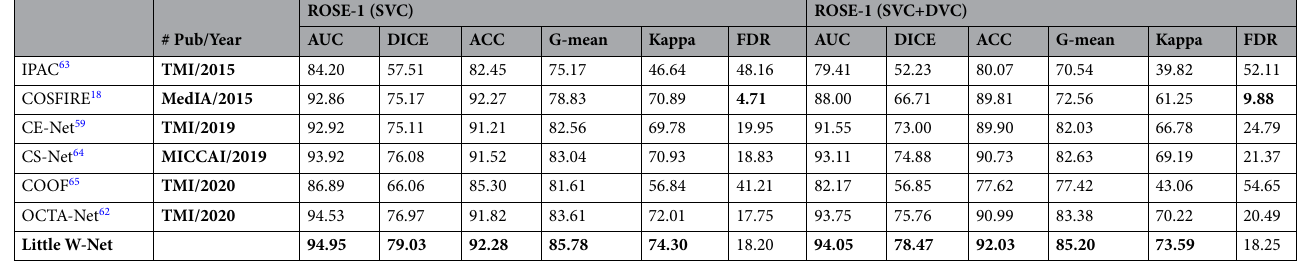
Table 6. Performance comparison for OCTA vessel segmentation on ROSE-1 (SVC and SVC+DVC). Best results are marked in bold.